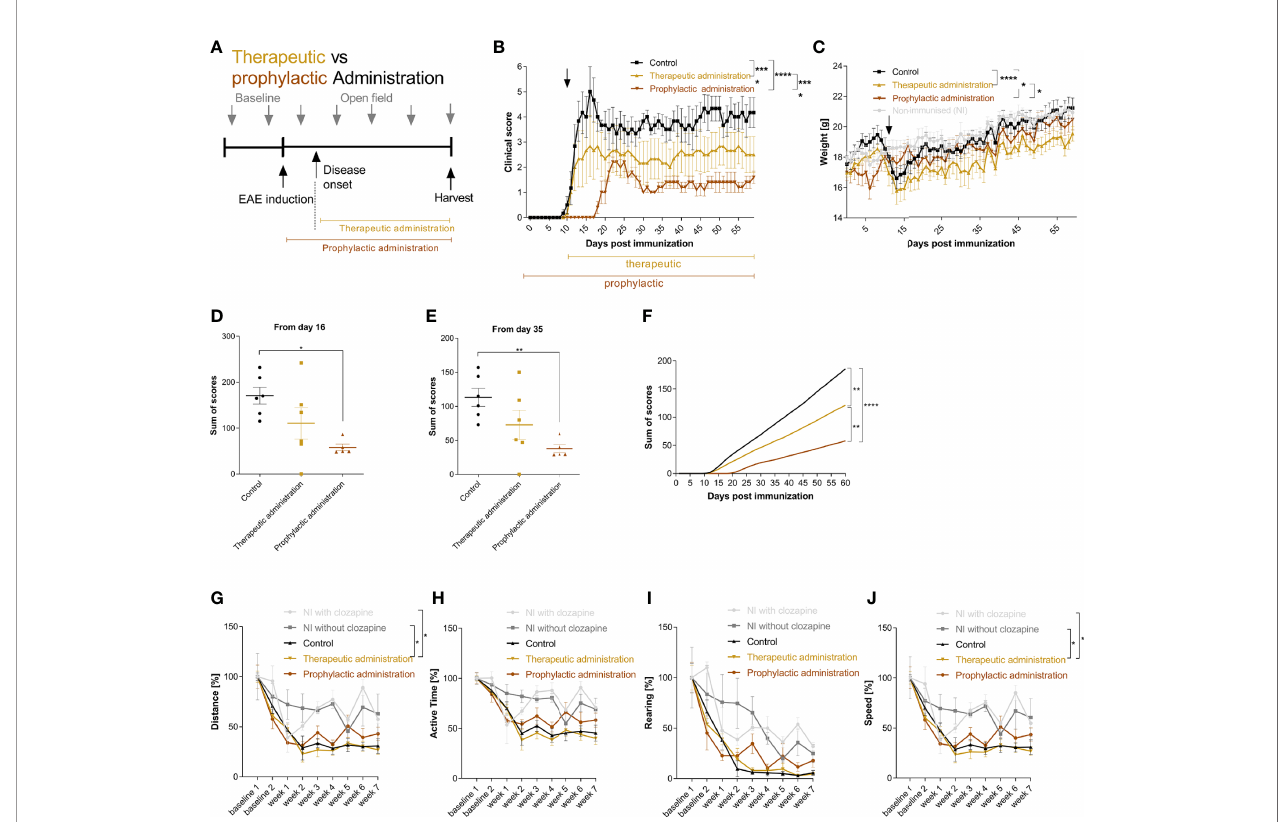
FIGURE 3 | Therapeutic and prophylactic administration ameliorate chronic EAE. (A) MOG-immunized C57BL6/J mice (female, 8 weeks old) were treated with 15 mg/kg from day 0 (prophylactic administration) or from day 11 (therapeutic administration, 50% of mice showed clinical signs at this timepoint) once a day.